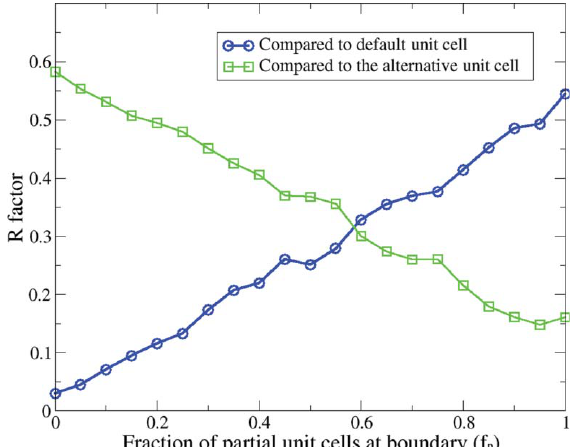
Figure 6 The R factors between the recovered patterns and the default (or the alternative) unit-cell transforms [equation (10)]. The trend clearly indicates that the recovered patterns drift away from the default unit cell and toward the alternative unit cell, as larger fractions of crystal boundary are occupied by partial unit cells.